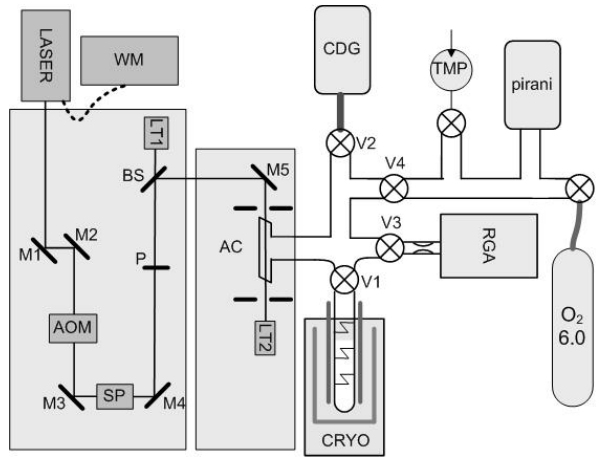
Figure 1. Measurement setup. AOM – Accousto-Optic Modulator; BS – Beam Splitter; CDG – Capacitive Diaphragm Gauge (Bara- tron); CRYO – cryogenic ozone generator; LT – Light Trap; M – Mirror; RGA – Residual Gas Analyser (Quadrupole mass spectrom- eter); TMP – Turbo Molecular Pump; V – Valve; WM –